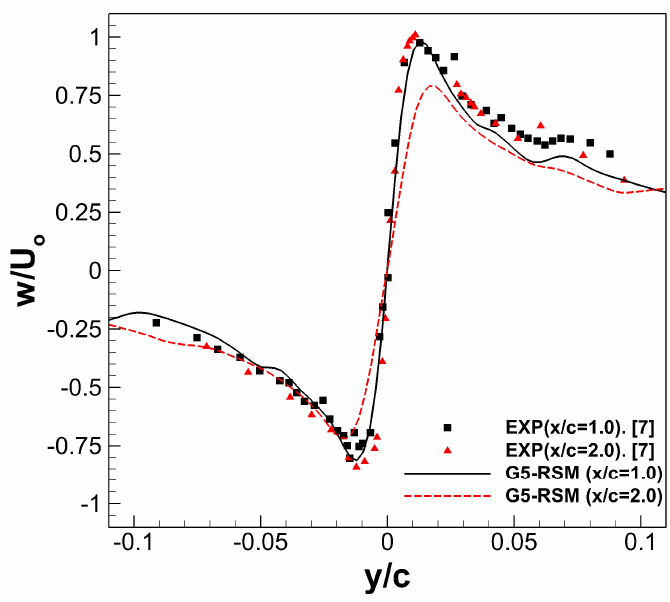
Figure 5. Vertical velocity profiles at the sections of x/c = 1.0 and 2.0.